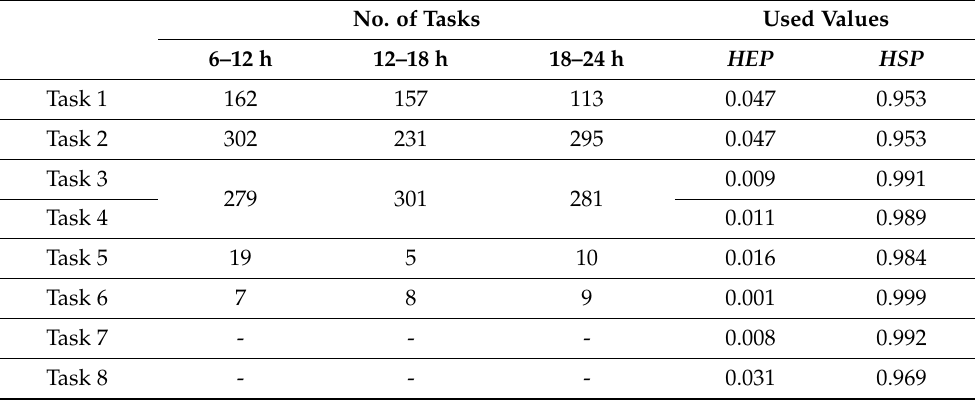
Table 14. Final overview of workplace